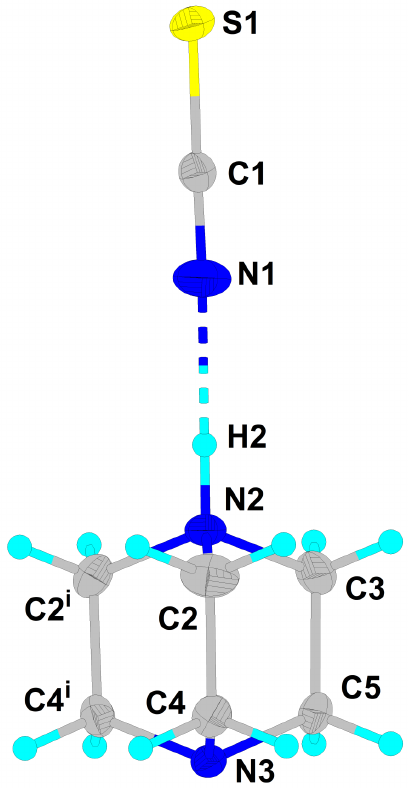
Figure 6. The crystal structure of 4 . ( a ) Infinite chains running along 100 crystallographic directions; ( b ) packing of above chains.